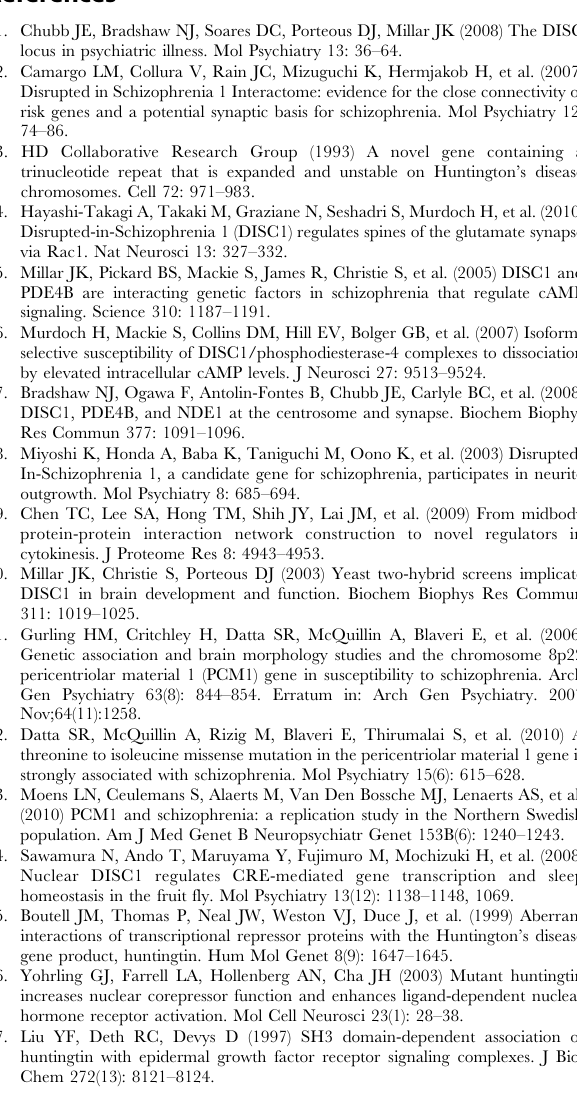
Figure S1 DISC1 Interactome Network 1. Only direct interactions were used. Molecules in the input list are in filled in grey. (JPG) Figure S2 DISC1 Interactome Network 2. Only direct interactions were used. Molecules in the input list are in filled in grey.